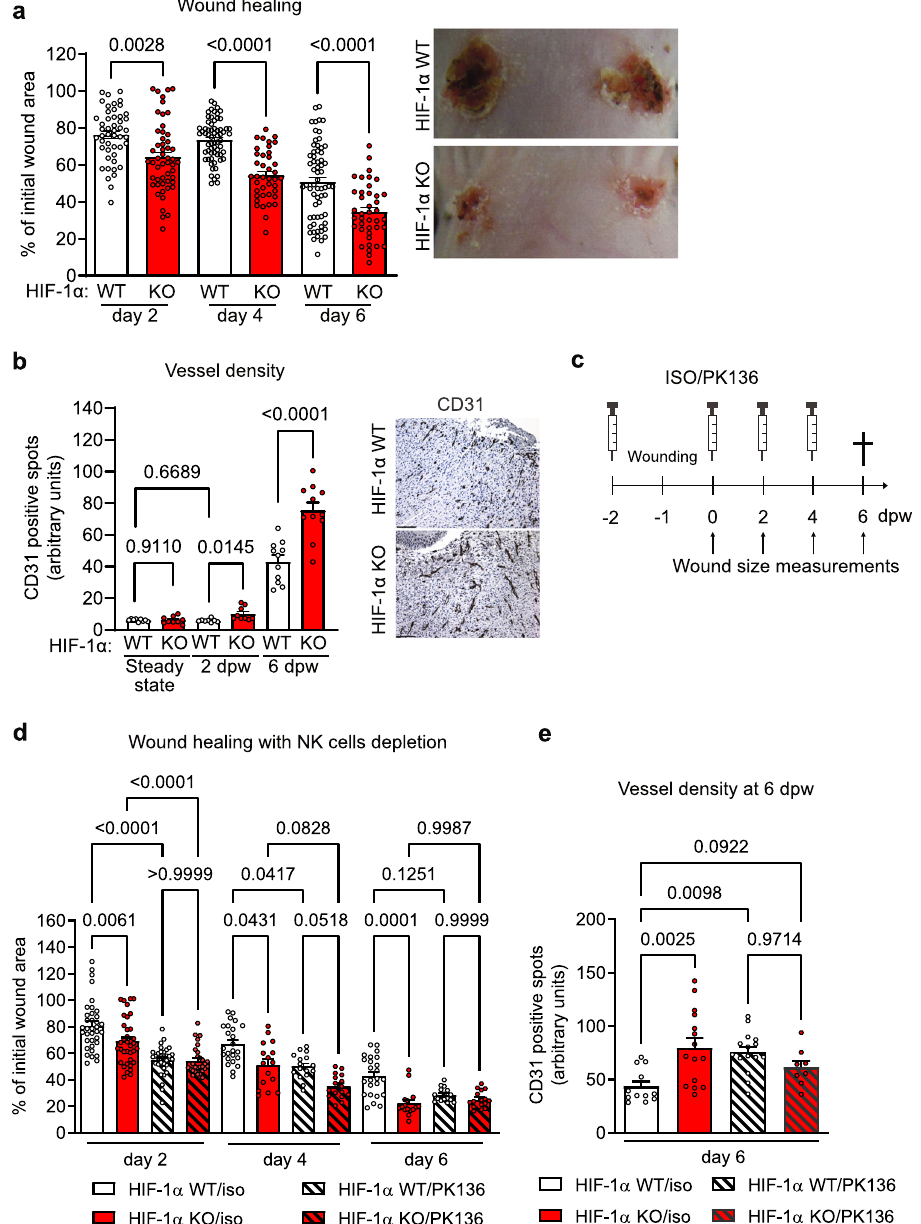
Fig. 1 Genetic targeting of HIF-1 α in NKp46 + cells accelerates wound healing. a Left, quanti fi cation of wound areas at 2, 4 and 6 days post wounding (dpw) in WT and HIF-1 α KO animals in relation to their respective initial size at day 0. Pooled data of 4 experiments, (day 2, n = 48, WT and n = 52, HIF-1 α KO, p = 0.0028; day 4 and 6, n = 64, WT and n = 40, HIF-1 α KO, p < 0.0001), one-way ANOVA test. Right, macroscopic images of wounds from WT and HIF-1 α KO animals, at 6 dpw. b Left, quantitative analysis of CD31-positive endothelial cells at steady state skin and in wounds at 2 and 6 dpw (steady state, n = 9; day 2, n = 11; day 6, n = 8) and HIF-1 α KO (steady state, n = 9; day 2, n = 9, day 6, n = 9), pooled data of 3 experiments, one-way ANOVA test. Right, representative CD31, endothelial cell immunohistochemistry in skin wounds, scale bar, 100 μ m. c Experimental layout for NK1.1 + cell depletion during wound healing. Control animals received i.p. injections of isotype control antibody. ISO - isotype control antibody; PK136 - NK1.1 antibody. d Quanti fi cation of wound areas at day 2, 4 and 6 pw in WT and HIF-1 α KO animals with or without NK1.1 + cell depletion. Pooled data of 2 different experiments for 2 dpw (day 2, n = 36 for WT/iso, n = 32 for HIF-1 α KO/iso, n = 36 for WT/PK136, n = 28 for HIF-1 α KO/PK136; day 4 and 6, n = 24 for WT/iso, n = 16 for HIF-1 α KO/iso, n = 16 for WT/PK136, n = 16 for HIF-1 α KO/PK136), two-ways ANOVA test. e Quantitative analysis of CD31 + endothelial cells in skin wounds at 6 dpw from WT and HIF-1 α KO animals with or without NK1.1 + cell depletion, ( n = 12 for WT/iso, n = 15 for HIF-1 α KO/ iso, n = 14 for WT/PK136, n = 8 for HIF-1 α KO/PK136), two-ways ANOVA test. Data are mean values ± experiments with puri fi ed splenic NK cells followed by in vitro stimulation with PMA/ionomycin, which showed reduced IFN- γ and GM-CSF expression in HIF-1 α null NKp46 + cells (Supple-